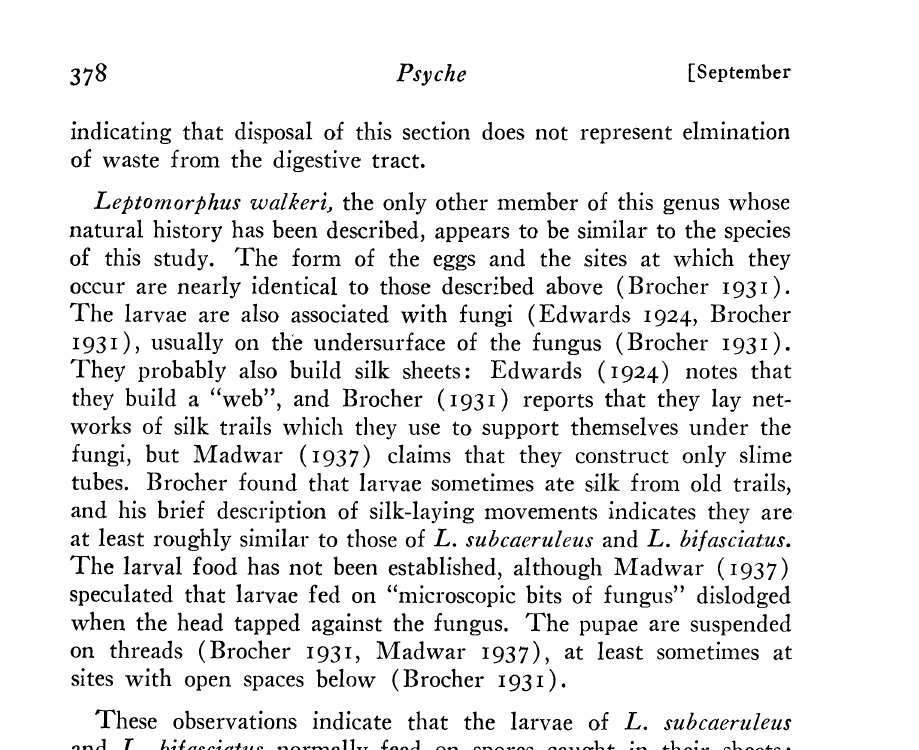
Fig. 6. Spinning motions of L. subcaeruleus larvae. The attachments made by one larva in a typical series of swings are represented by dark bars in /. The sequences of successive attachments during four typical series of swings by two individuals are shown in B. The frequency with which an attachment in one zone (labelled in /) was followed by an attachment in another zone is indicated by the width of the arrow running from the first to the second